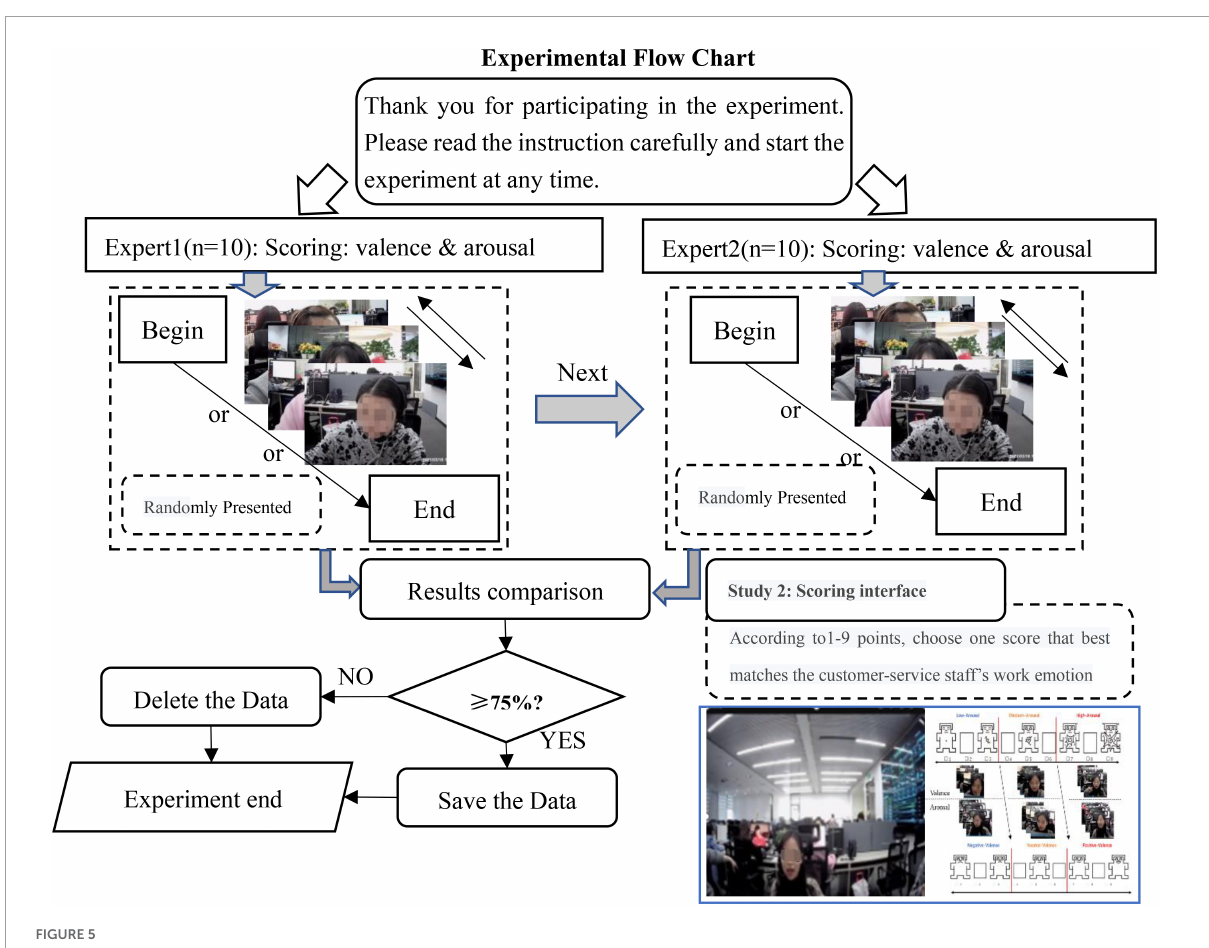
FIGURE5 Experimental flow chart of Expert 1 &